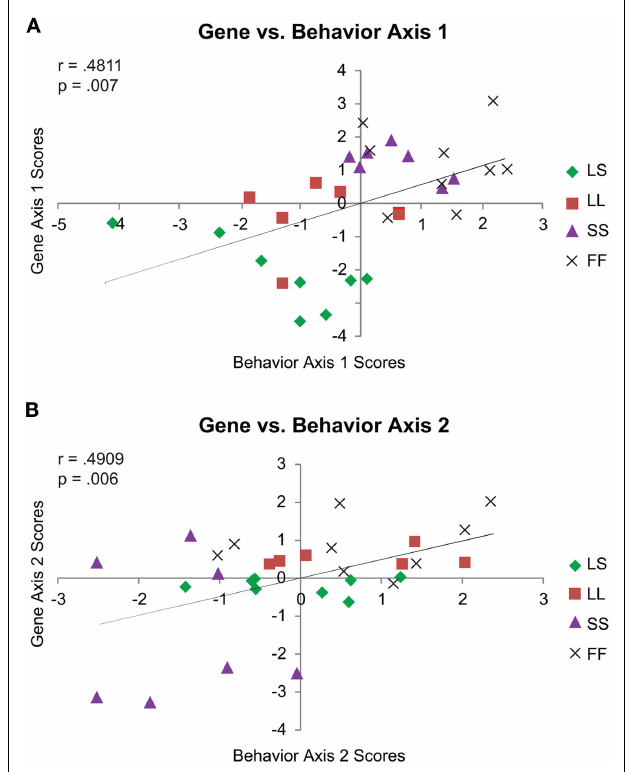
FIGURE 4 | Context-specific correlations for behavior vs. gene MDA scores. Behavior 1 and Gene 1 Pearson’s correlation (A) . Behavior 2 and Gene 2 Pearson’s correlation (B) . For both panels, behavior MDA scores are depicted on the x -axis and gene MDA scores on the y -axis. MDA score generation explicitly accounts for treatment group, and so although group membership is denoted by symbol (see panel legends), the correlations are calculated including all MDA scores for each axis. Only the correlations between the two main axes are